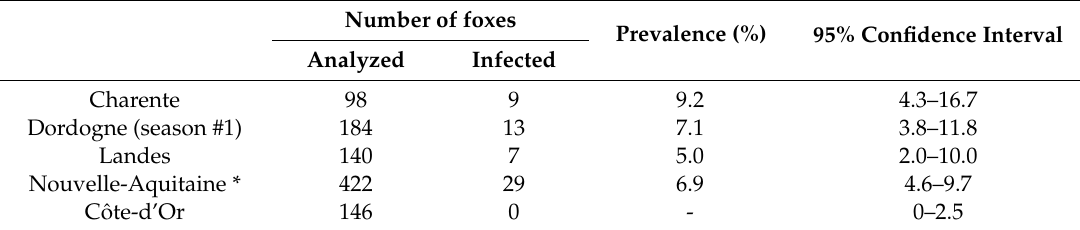
Table 3. M. bovis infection of foxes in three infected areas of Nouvelle-Aquitaine and in the core infected area of C ô te-d’Or,